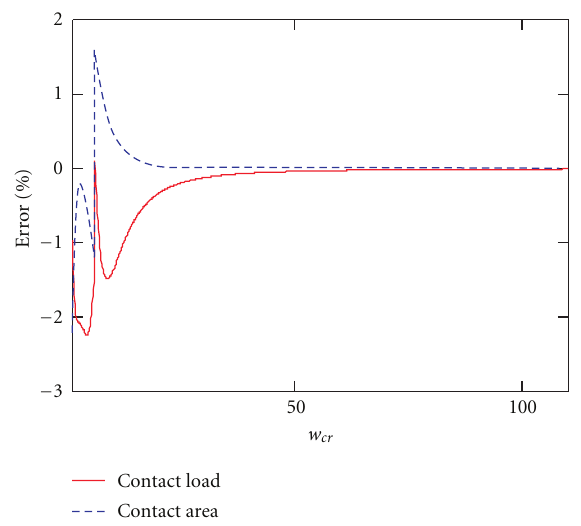
Figure 3: Comparison of the continuous functions for asperity contact force and area obtained through fusion ((11) and (12)) with the piecewise ((3), (4), and